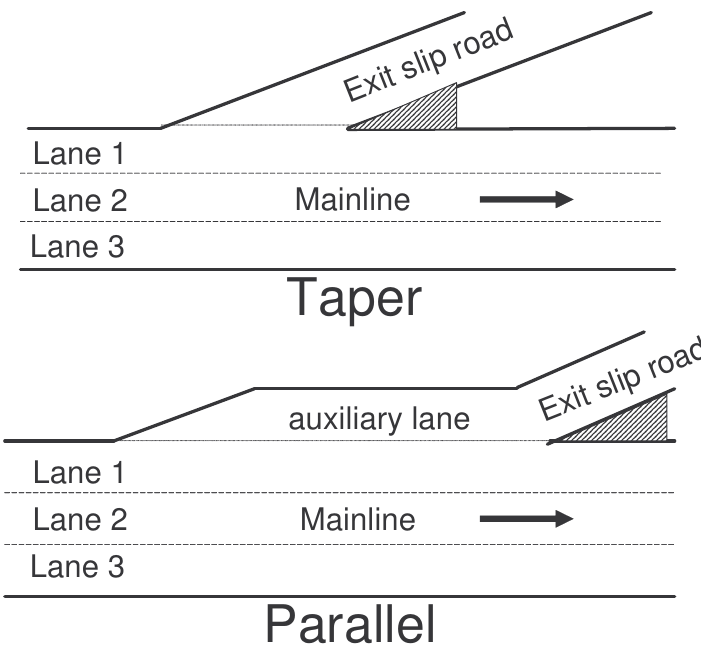
Figure 1. Two basic diverge designs (adapted from Wall and Hounsell, 2004) With the Taper diverge, drivers wishing to leave the motorway need to stay in lane 1 prior to the exit and then move directly into the exit slip road whereas with the Parallel diverge, drivers need to stay in lane 1 and then move into the auxiliary lane that feeds into the exit slip road. An auxiliary lane provides extra capacity, reducing the risk of traffic blocking back onto the main carriageway. These layouts can also be associated with a lane drop; this occurs when the number of lanes downstream of the diverge is less than the number of lanes upstream of the diverge as a result of the inside mainline lane(s) feeding into the exit slip road. Lane drops are only usually provided when there is a high diverging proportion or when there is a high merging proportion requiring a lane gain upstream of the diverge. There may also be policy, layout or economic reasons for their